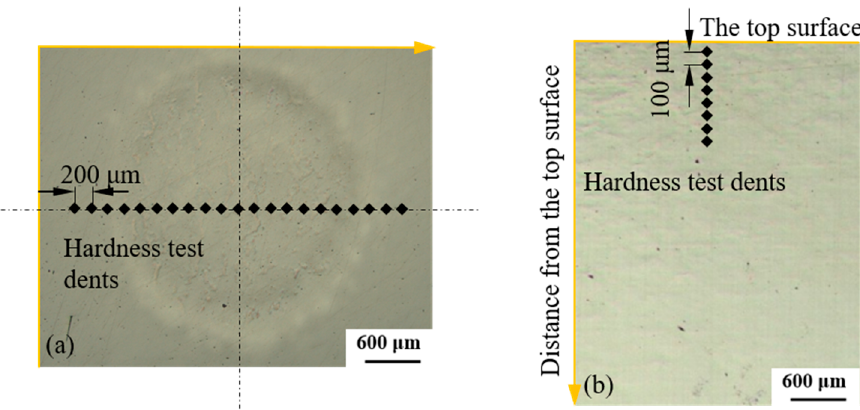
Figure 9. Schematic diagram of the hardness testing points ( a ) Surface microhardness testing ( b ) Microhardness testing in the cross-sectional direction.